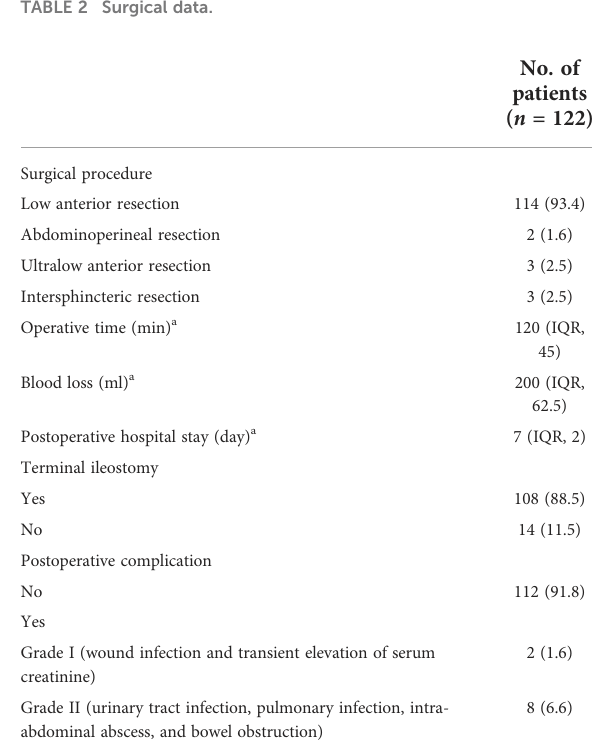
TABLE 2 Surgical data.